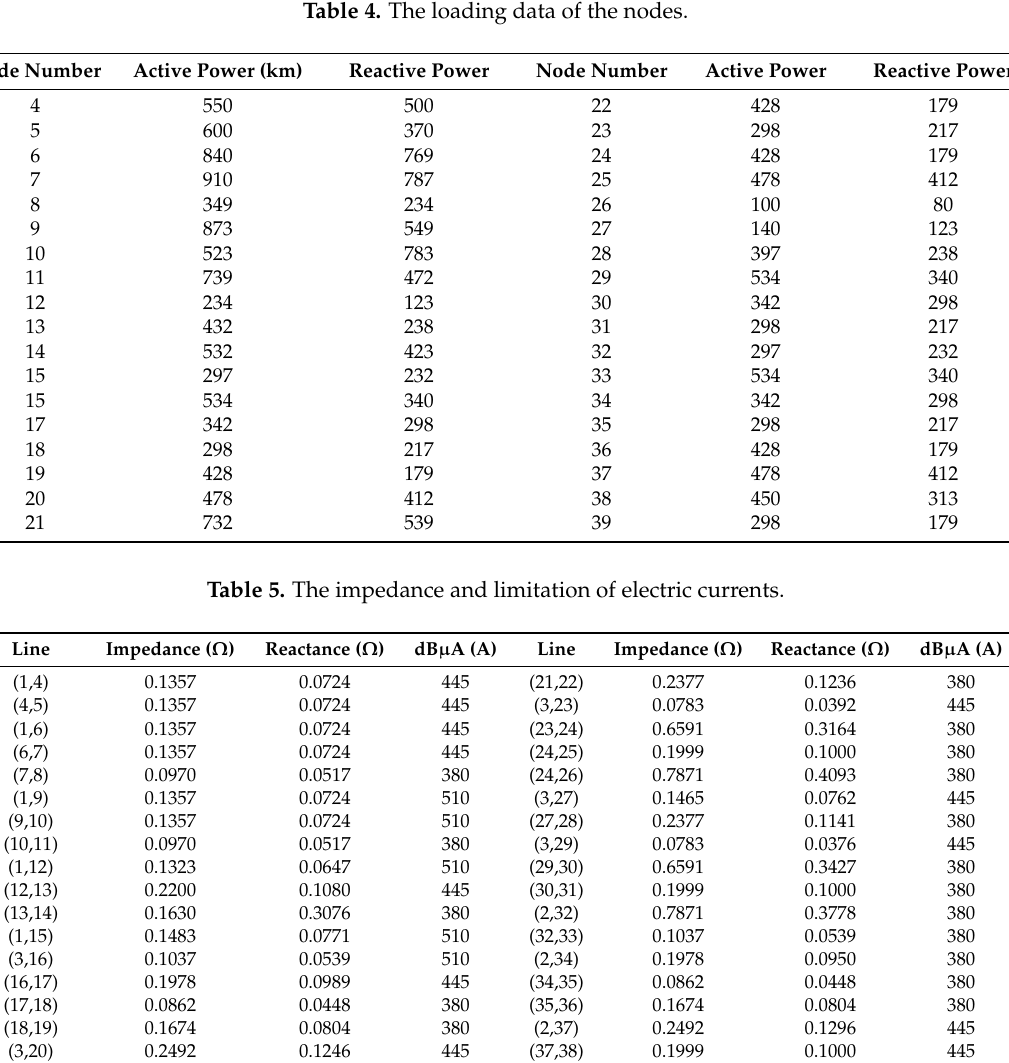
Table 4. The loading data of the nodes.